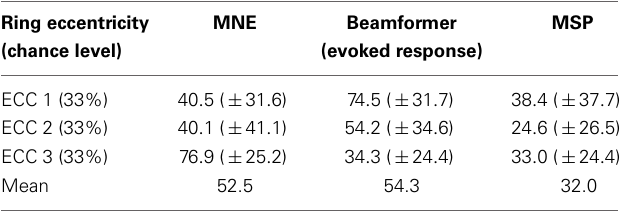
subregion, whilst lower field quarter-ring stimuli to the left dorsal subregion. Results are presented separately for upper or lower visual field locations, averaged over stimuli and partici- pants ( Figure 8A ). Reconstructing sources with the